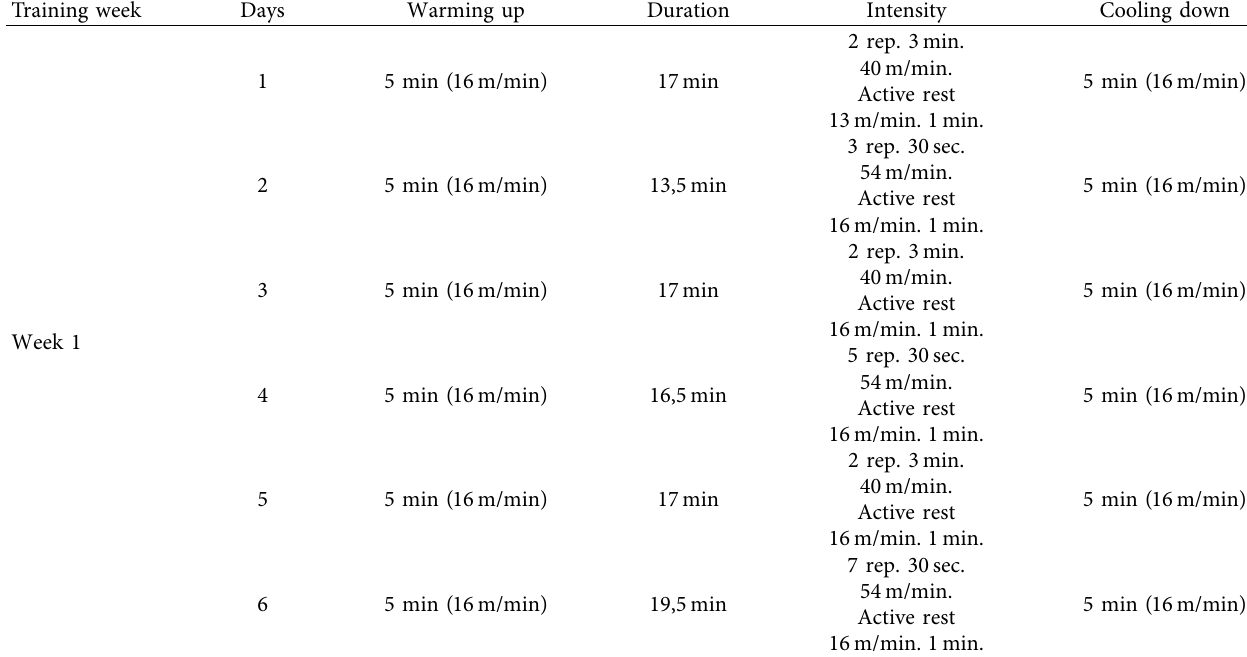
Table 2: Te interval training protocol